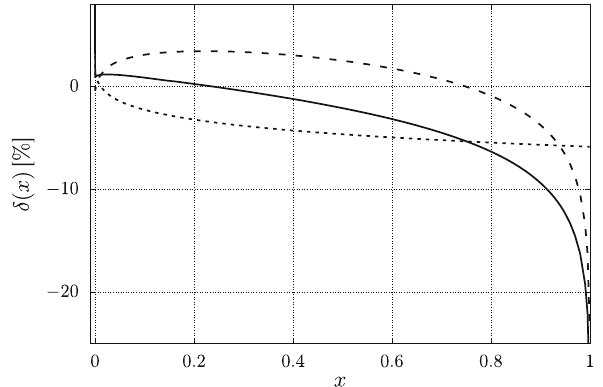
Fig. 3 The total NLO correction δ( x ) for the decay Σ 0 → Λ e + e − (solid line) in comparison to its constituents. The virtual correction δ virt ( x ) is depicted as a dotted line. The bremsstrahlung correction δ BS ( x ) is shown as a dashed line. The divergent behavior of δ( x ) near x = ν 2 ≈ 0 has the origin in the electromagnetic form factor F 1 ( x ) and is connected to the Coulomb self-interaction of the dilepton at the threshold. This divergence is integrable